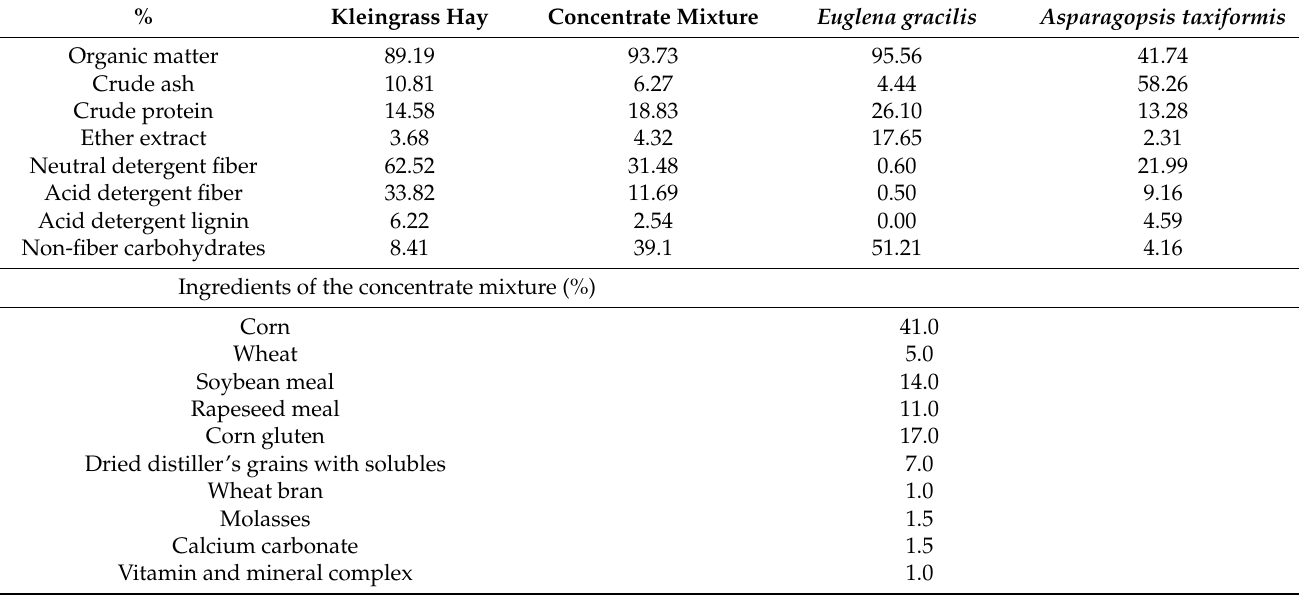
Table 1. Chemical composition (% in dry matter) used for 24 h in vitro incubation.